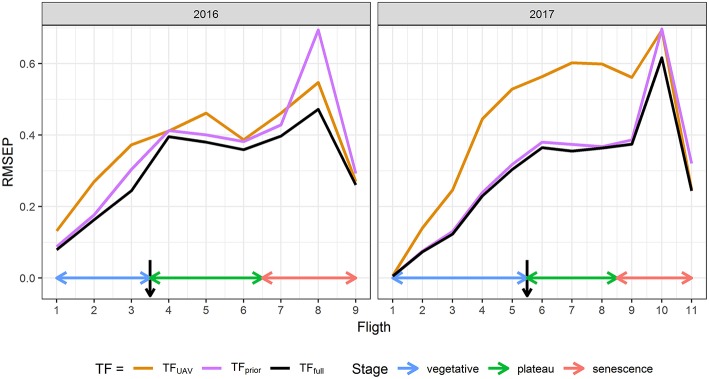
Comparison between the Root Mean Squared Error of Prediction (RMSEP) of TFfull, TFUAV, and TFprior for each flight date in 2016 and 2017. TFfull is the transfer function based on the eight predictors {r450*, r532*, r568*, r675*, r730*,d, itop, ϕGDD}, while TFUAV is based only on {r450*, r532*, r568*, r675*, r730*} and TFprior only on {d, itop, ϕGDD}. Black arrows indicate flowering time.